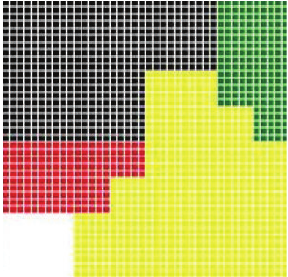
Figure 3: The initial solution got by